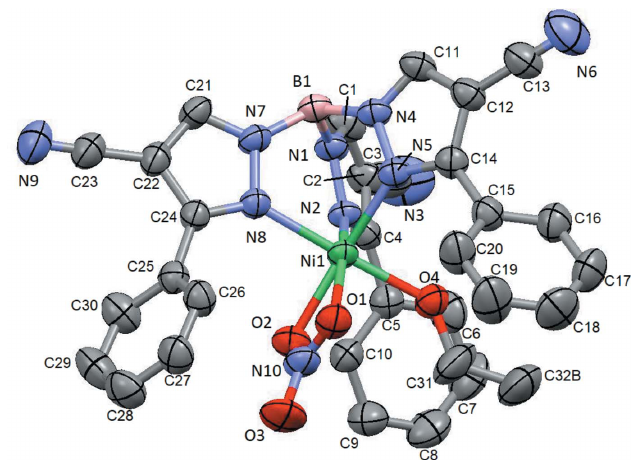
Figure 1 The title compound with displacement ellipsoids drawn at the 50% probability level. H atoms have been omitted for clarity. Only the major component of the Me atom is shown.